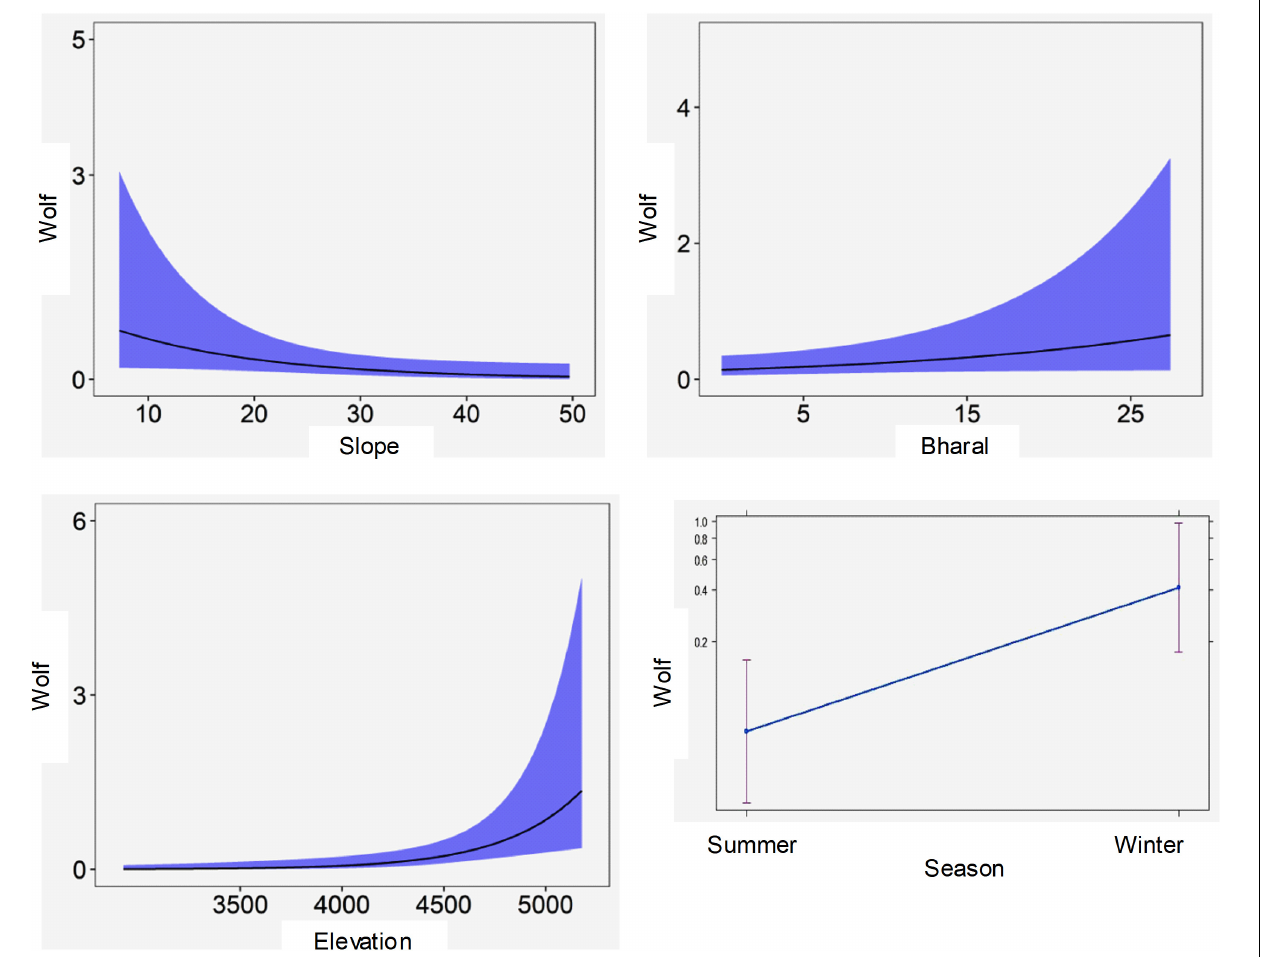
FIGURE 2 | Predicted relationship between the woolly wolf capture rate and habitat variables: elevation, slope and season, and capture rate of prey species: bharal as determined by the generalized linear mixed models in the Nelang valley of the Gangotri National Park, Uttarakhand, India. The y -axis of each graph depicts the photo-capture rate and the x -axis depicts the variable value (elevation in m, slope in degree, bharal capture rate/100 days).